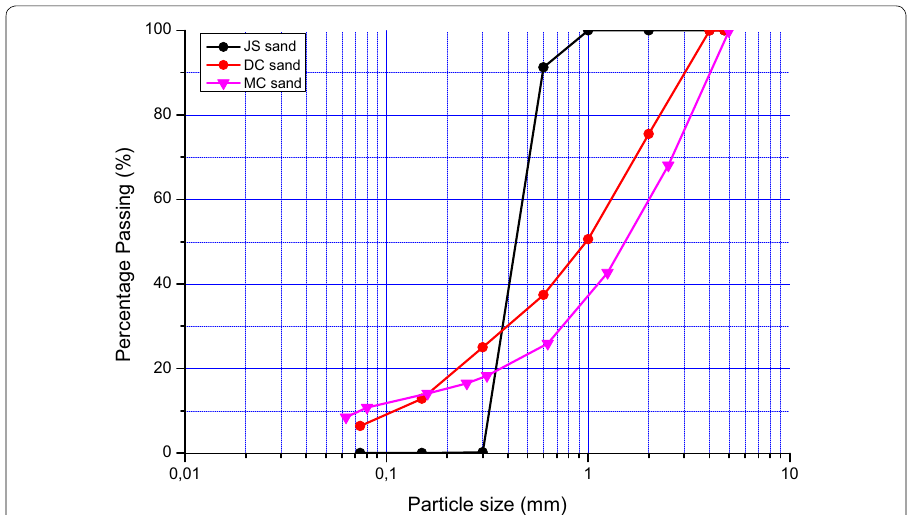
Fig. 5 Grain size distributions Curves of three sand samples: Jumunjin silica sand, Dissa calcareous sand and Matmata calcareous